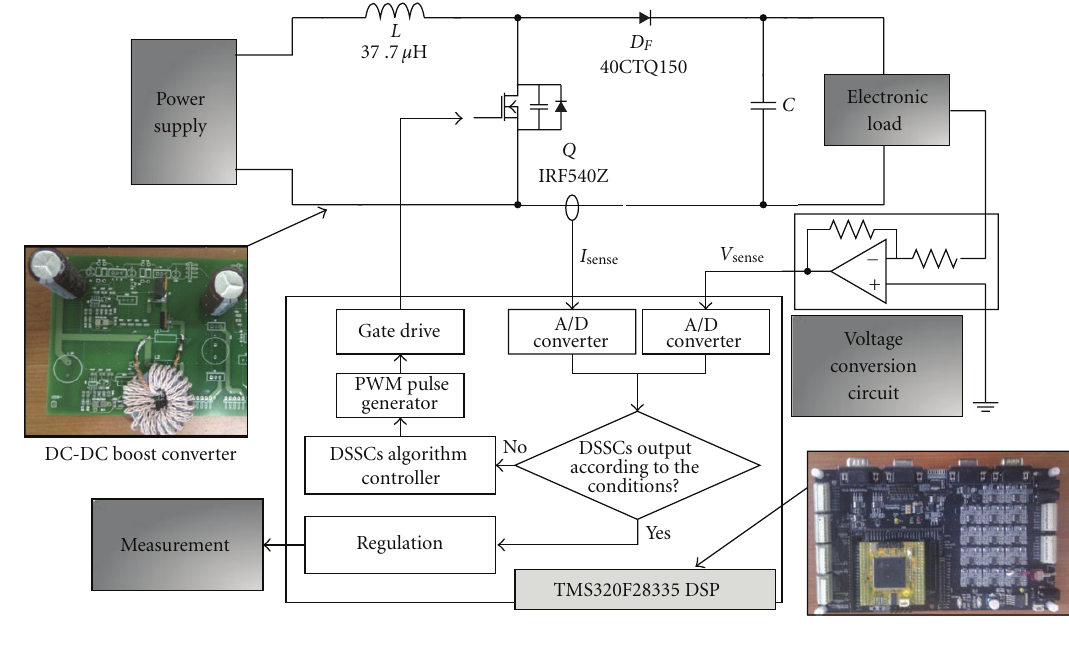
Figure 7: The block diagram of the SS.